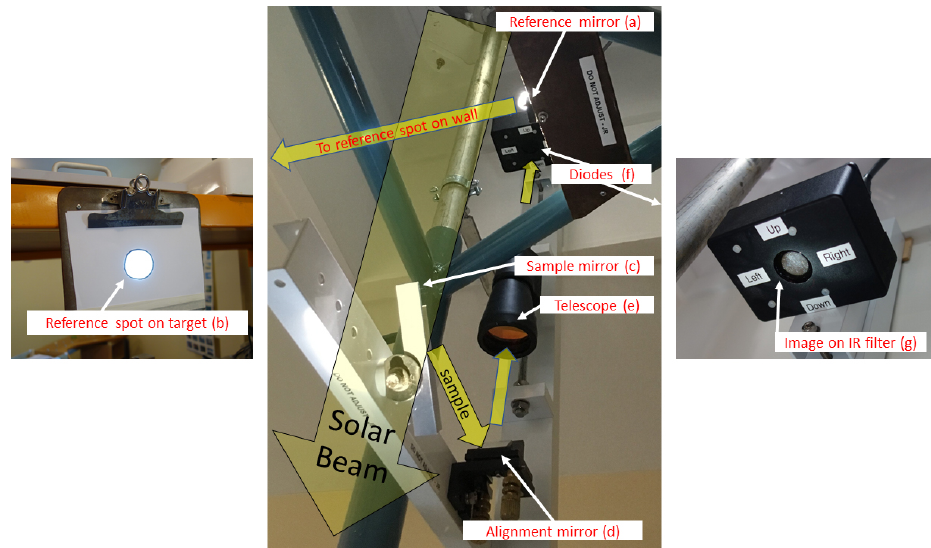
Figure 3. The optical feedback components identified. The main view is from the laboratory and looks upwards towards the roof-mounted solar